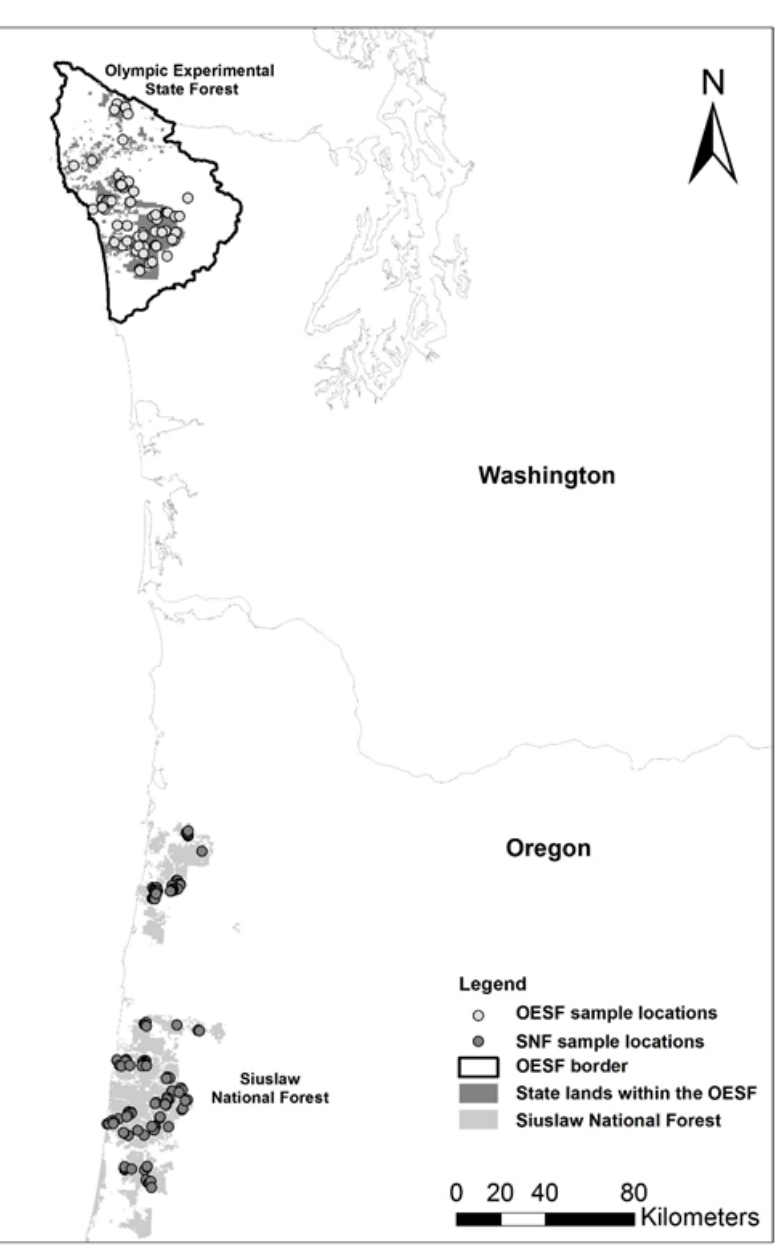
Figure 4. Map of sample sites in the Olympic Experimental State Forest (white dots) and Siuslaw National Forest (dark grey dots).